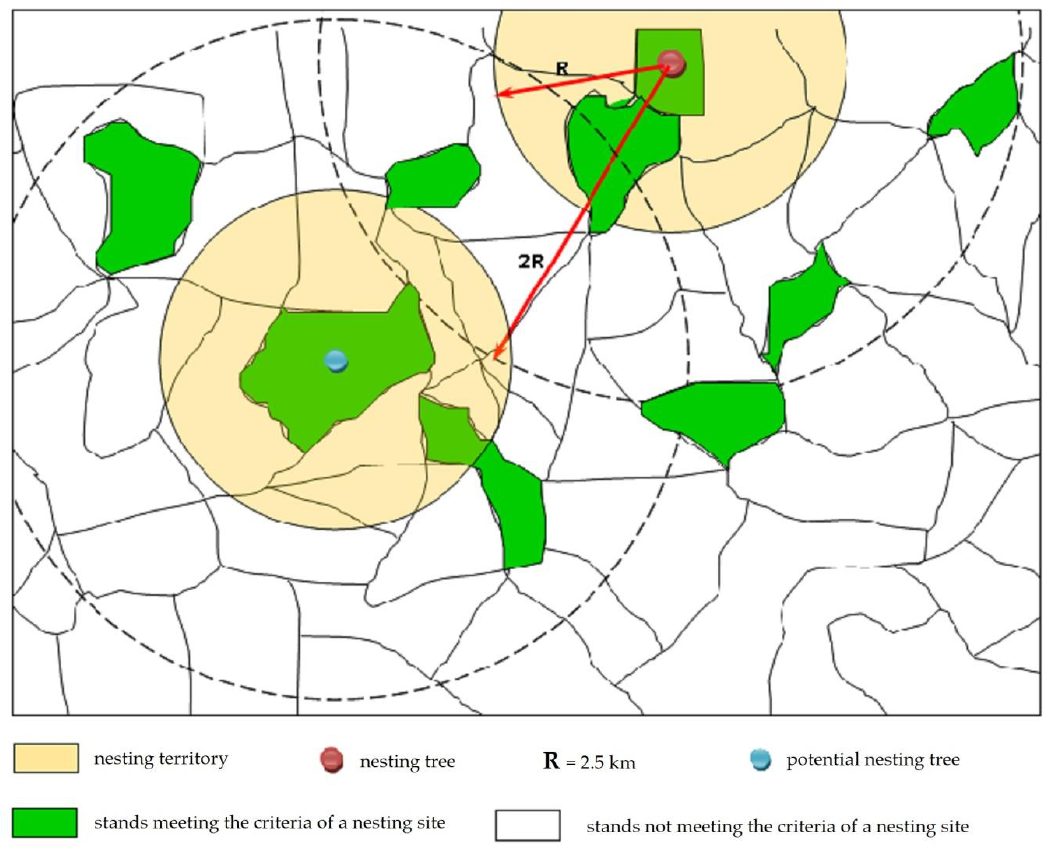
Figure 3. Method of identifying potential nesting territories.